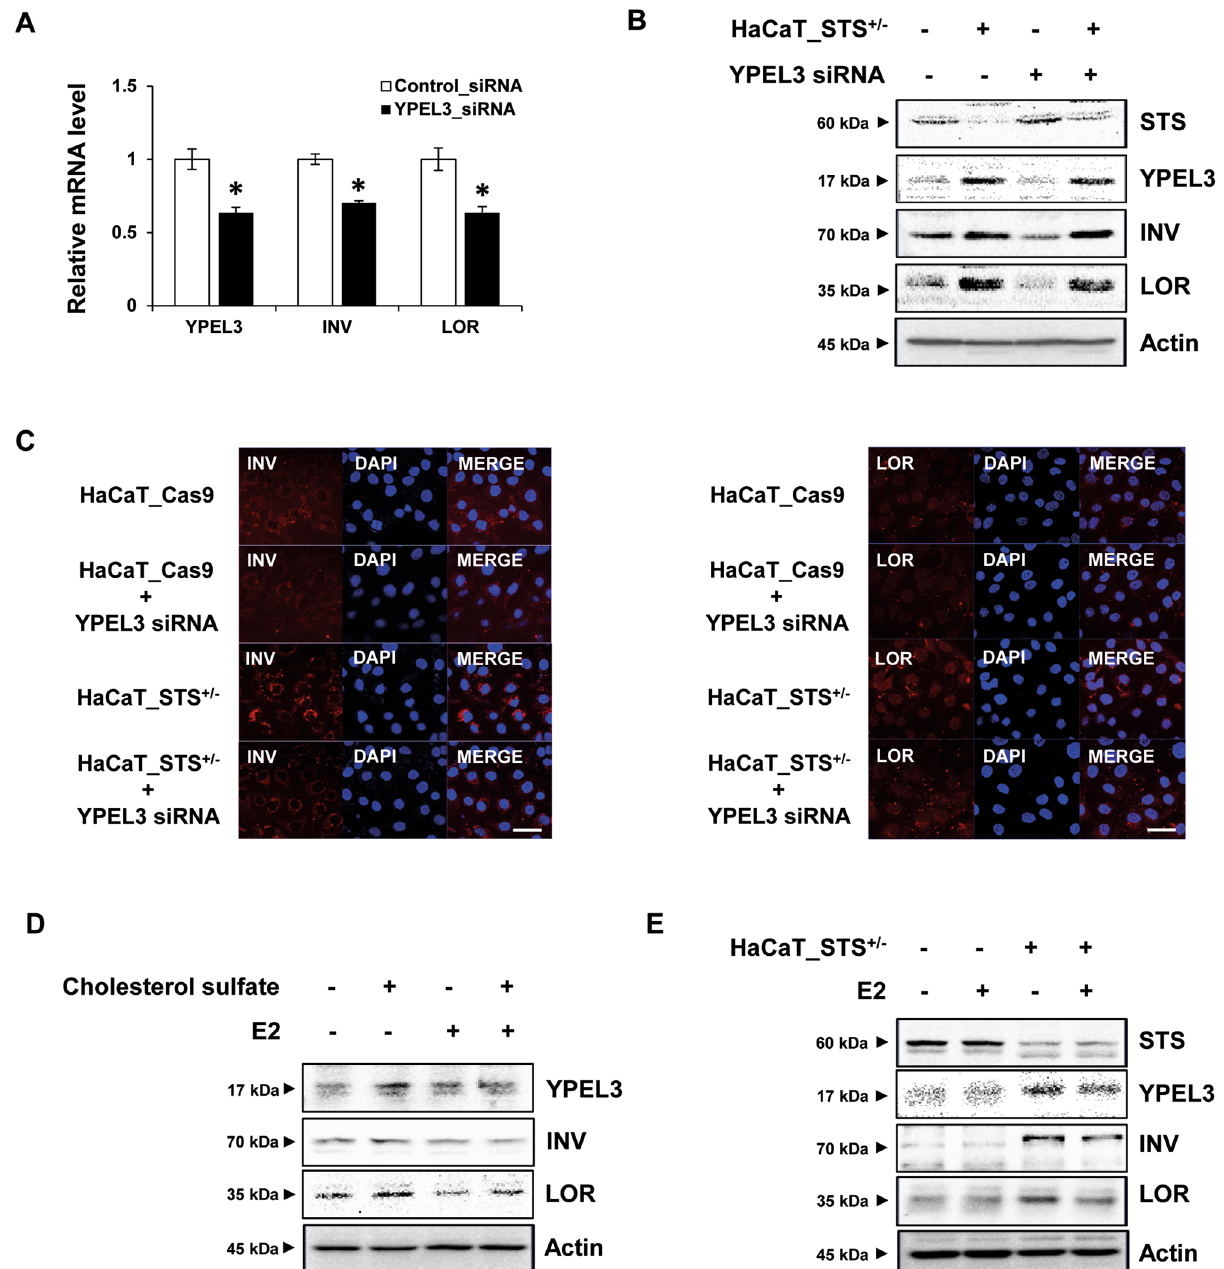
Figure 4. High YPEL3 levels in HaCaT_STS +/− cells increase the protein levels of keratinization markers LOR and INV. HaCaT_STS +/− cells were transfected with YPEL3 siRNA (50 nM) for 48 h. ( A ) Real-time qPCR was performed to detect the expression of YPEL3, INV and LOR mRNA. The data represent the mean ± SD (n = 3). ( B ) STS, YPEL3, INV and LOR protein levels were measured using western blot analysis. ( C ) Confocal analysis was performed to assess INV and LOR expression. Microscopy scale bar = 50 μm. ( D ) HaCaT cells were co-treated with cholesterol sulfate (20 μg/ml) and E2 (100 nM) for 24 h. YPEL3, INV and LOR protein levels were measured using western blot analysis. ( E ) HaCaT_STS +/− cells were treated with E2 (100 nM) for 24 h. STS, YPEL3, INV and LOR protein levels were measured using western blot analysis. *p <